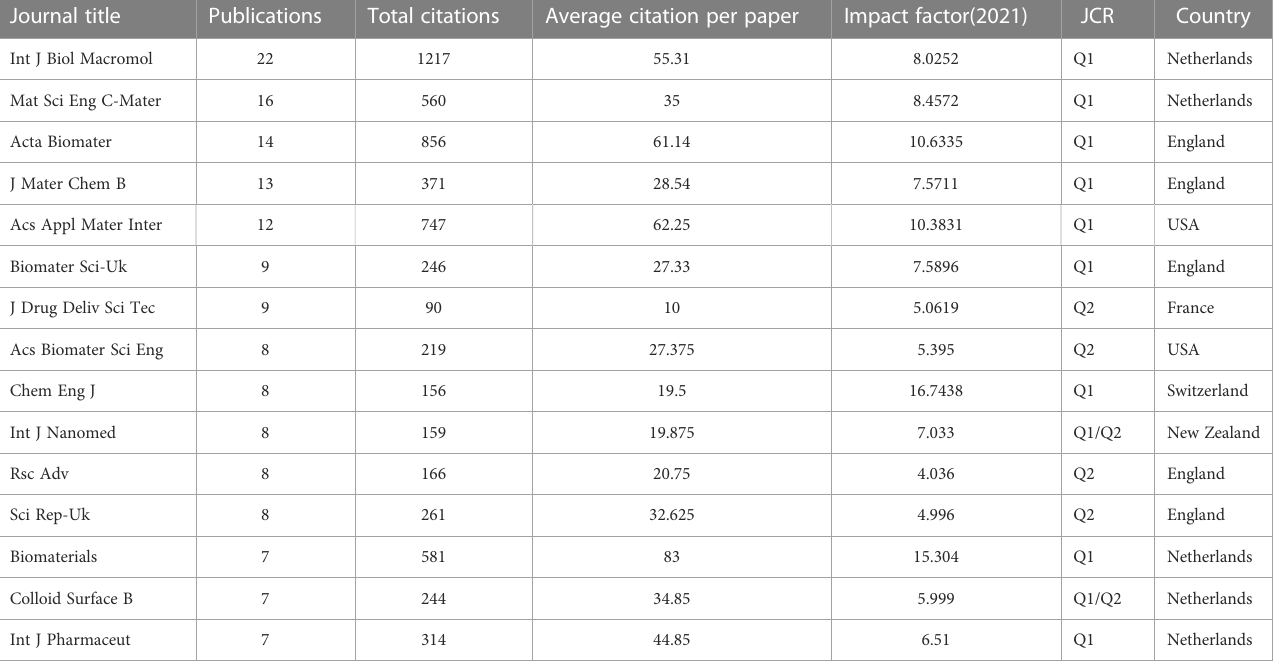
TABLE 4 The top 15journals in the fi eld of nanomaterials and diabetic wound healing.